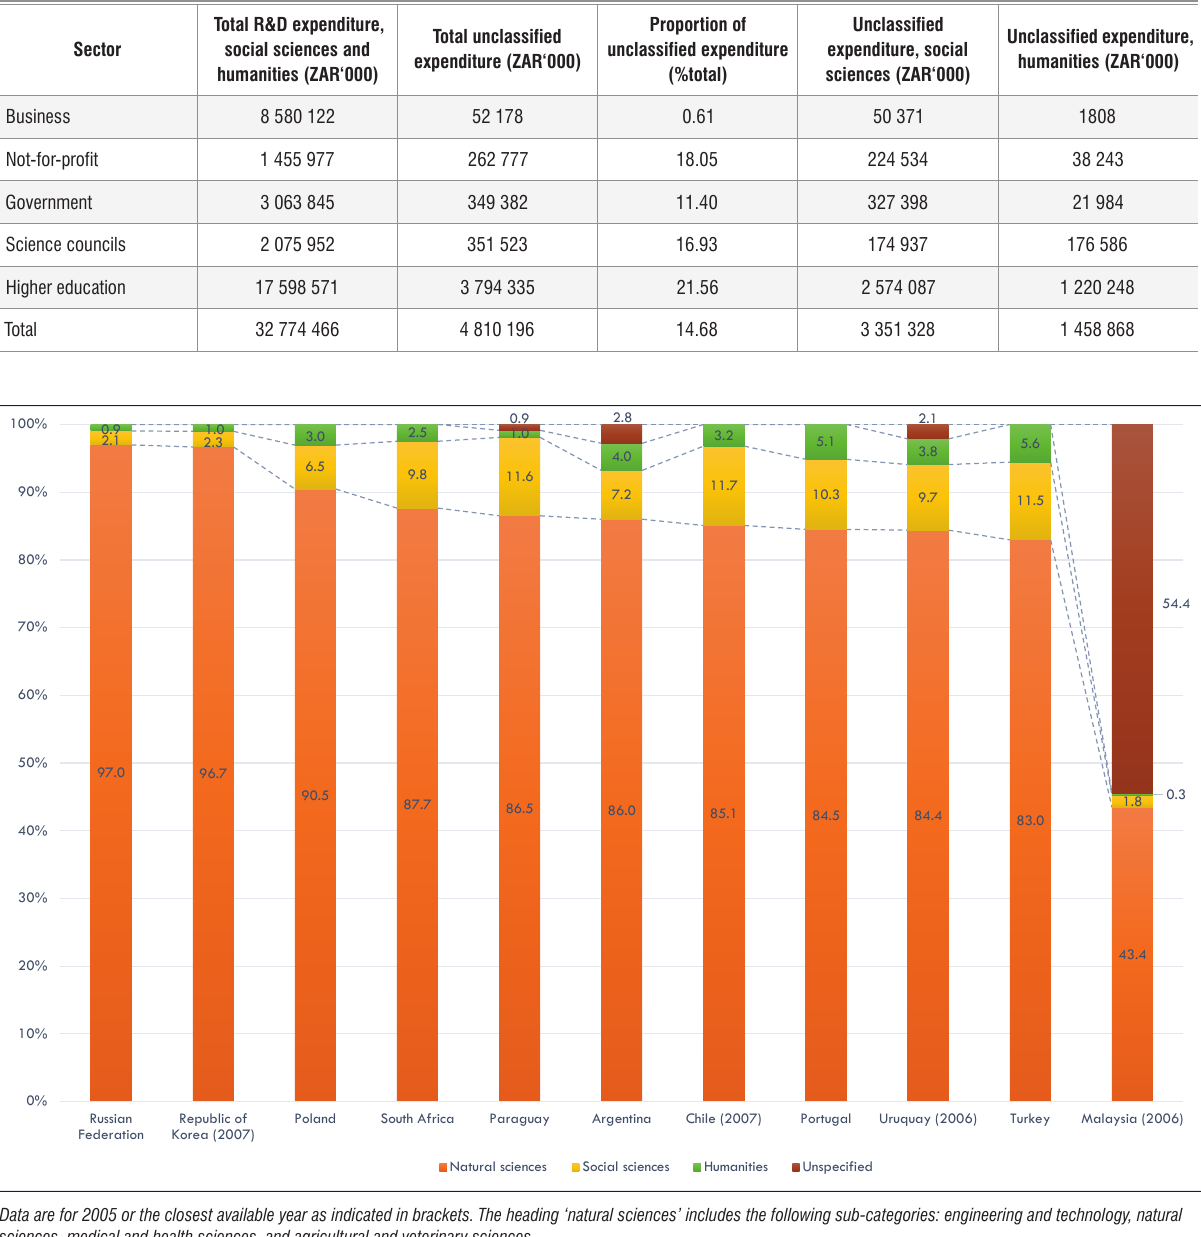
Table 2: R&D expenditure in the social sciences and humanities research fields, by sector, including unclassified expenditure (2005–2014)